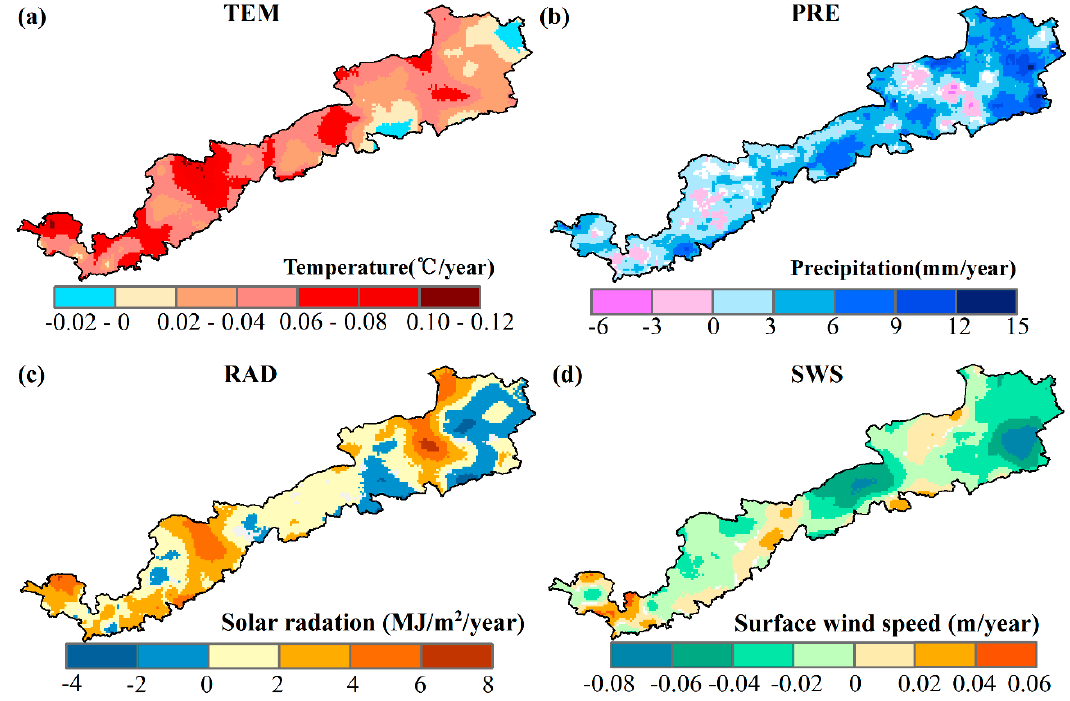
Figure 11. The spatiotemporal distribution of TEM ( a ), PRE ( b ), RAD ( c ), and SWS ( d ) in the APENC from 1982 to 2015. The insets show the temporal variations of each variable, and S1 , S2 , and S3 represent the slope in 1982–2015, 1982–2000, and 2000–2015, respectively. Only pixels with a P < 0.05 are represented.